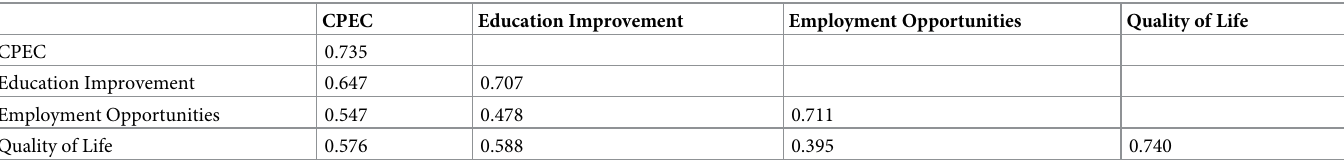
Table 4. Descriminant validity.